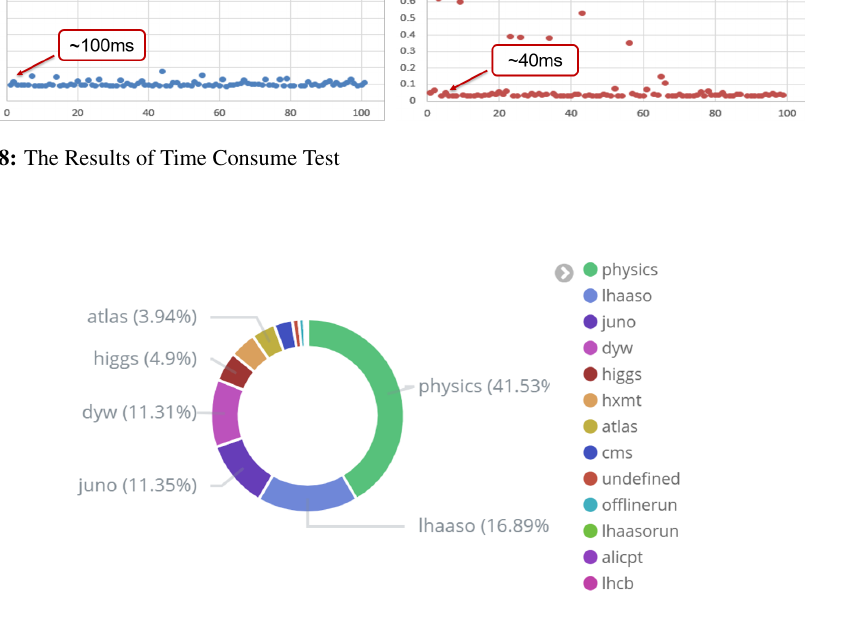
Figure 9: Job Statistics by